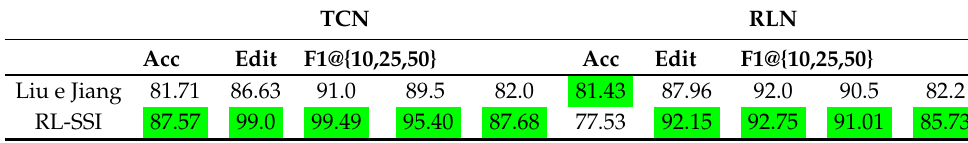
Table 4. Comparison of [22] and RL-SSI.